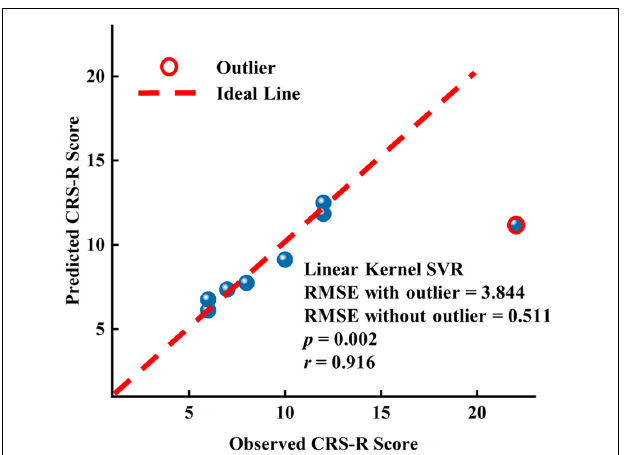
FIGURE 5 | Results of classification between patients at T0 and T1 by the mean FCSCC of the alpha band. p -value ( p = 0.004) were selected. For functional connectivity, the